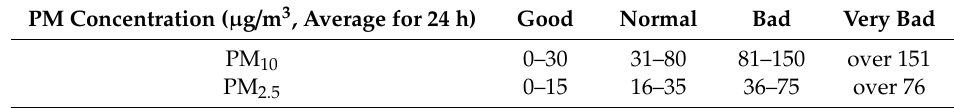
Table 2. Particulate matter forecast grade (2018).